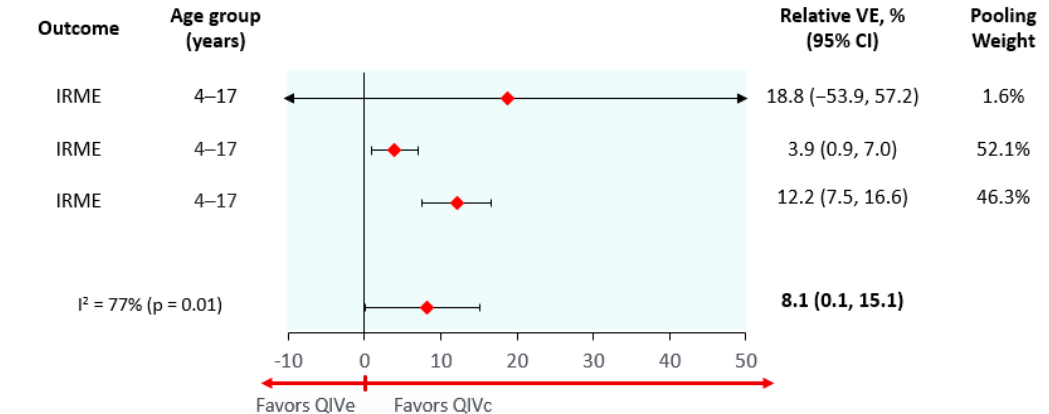
Figure 2. Meta-analysis of QIVc vs. QIVe, prevention of influenza related medical encounters in pediatric population. IRME: influenza-related medical encounters; VE: Vaccine Effectiveness; QIVe: Egg-based Quadrivalent Influenza Vaccine; QIVc: Cell-based Quadrivalent Influenza Vaccine.